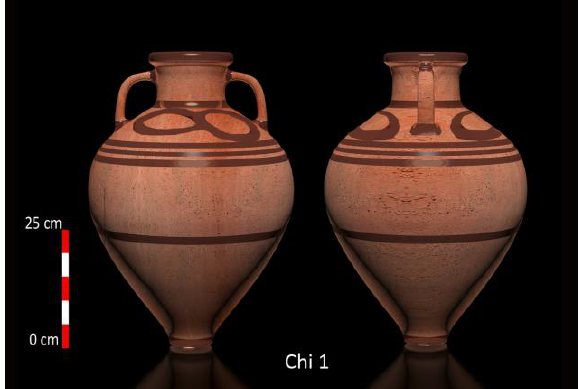
Figure 2. 3D model of a Chian amphora from 650